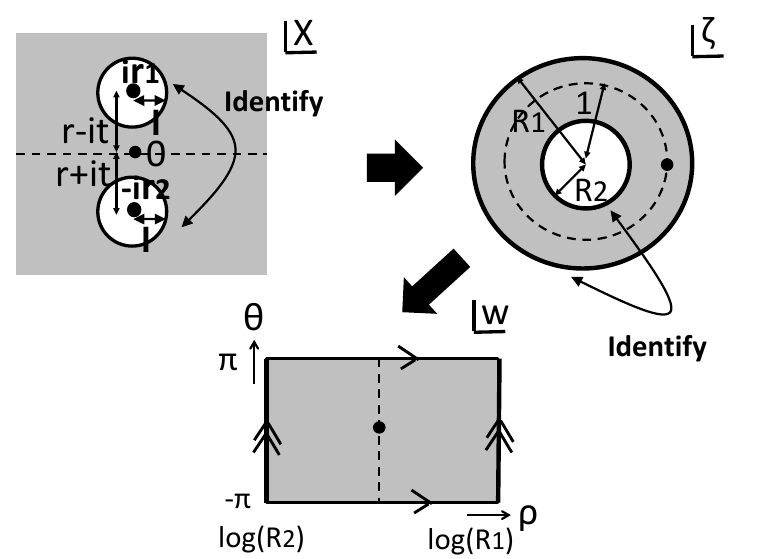
Figure 1 . The path-integral on a torus (cid:6) which describes a mixed state local quench and its conformal transformations into (cid:16) and w coordinate from the original X